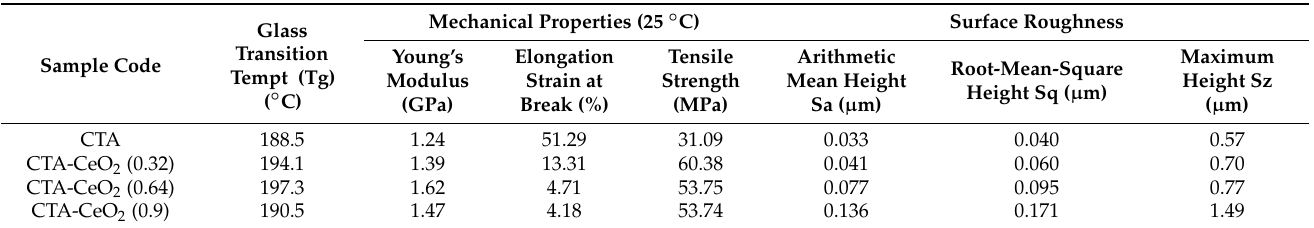
Table 2. Glass transition temperature, mechanical properties and surface roughness comparison of the synthesized